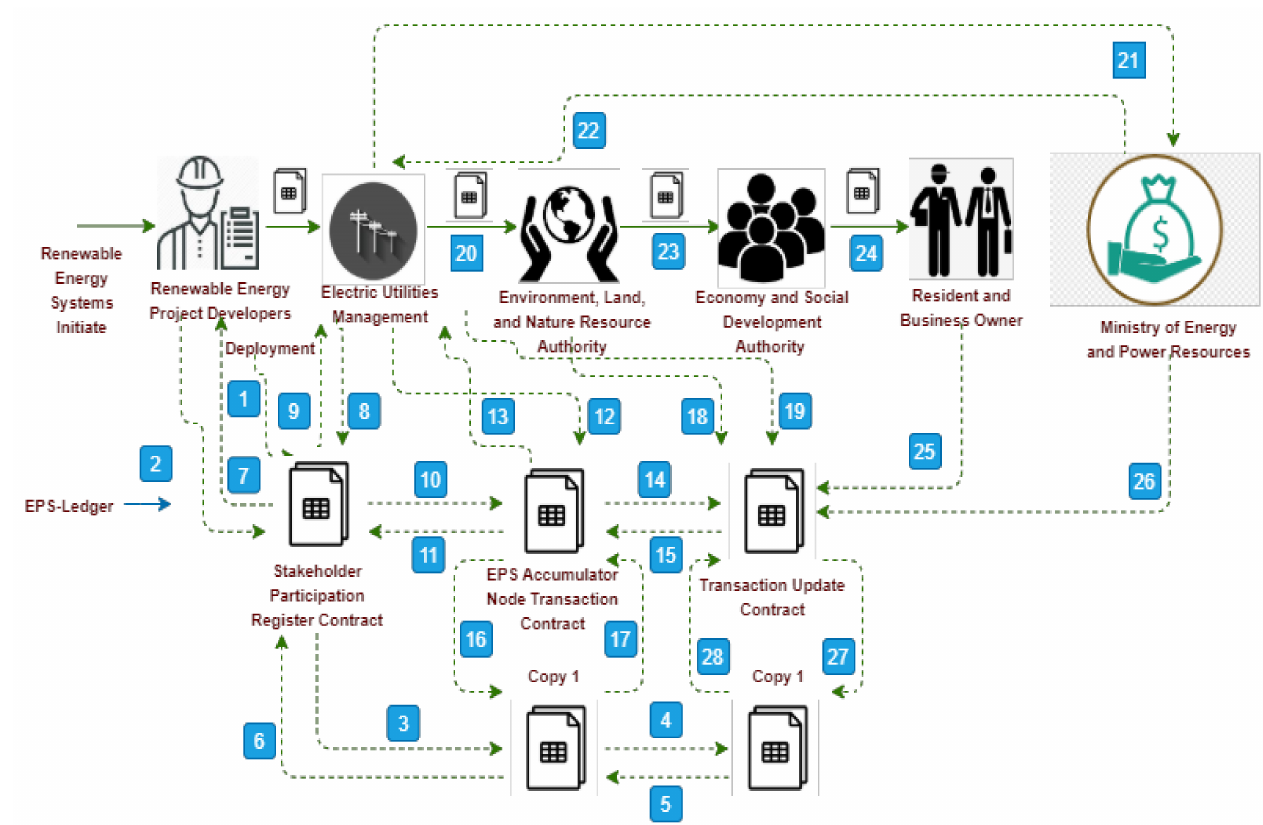
Figure 5. Event-based power node transaction execution process of the proposed blockchain Hyperledger Sawtooth-enabled distributed